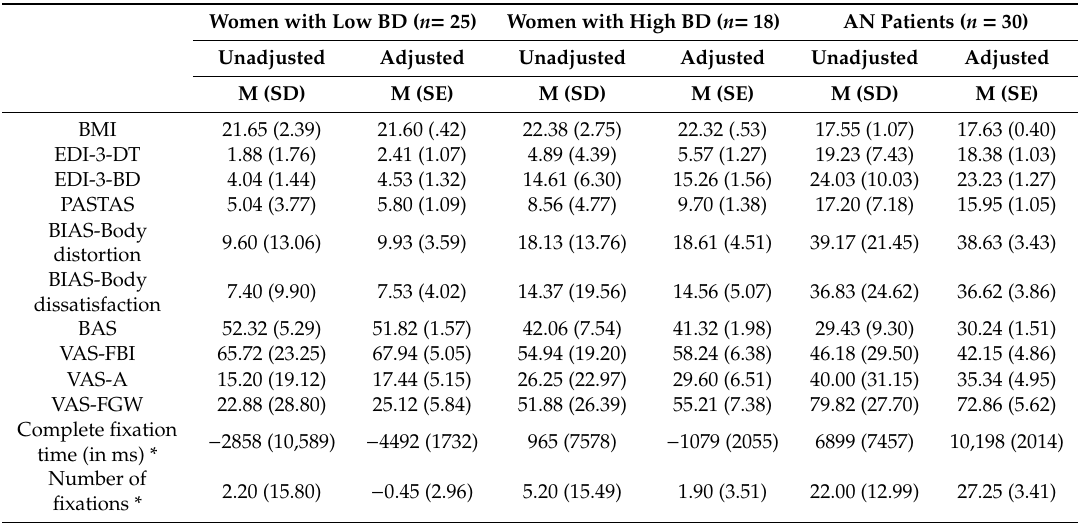
Table 1. Adjusted for age and unadjusted descriptive results. Mean (M), standard deviation (SD) and standard error